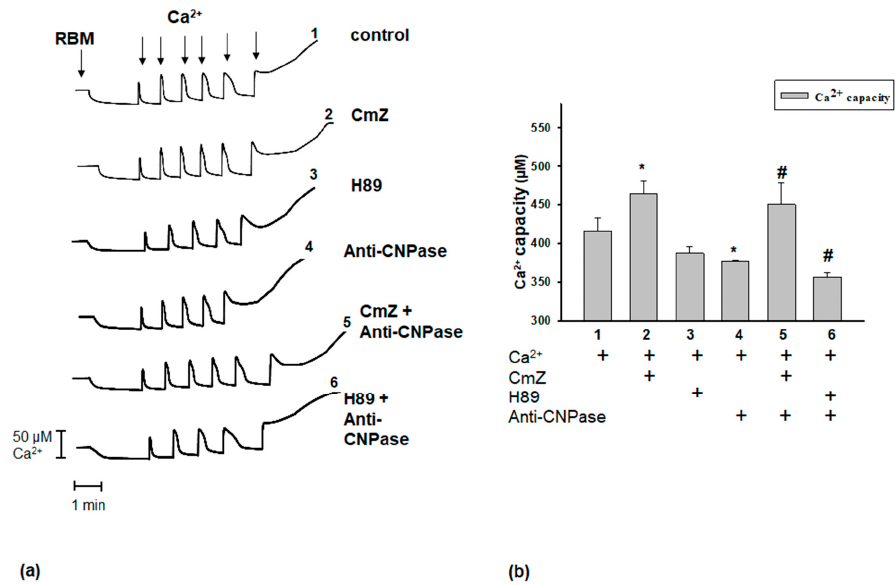
Figure 1. Effect of calmidozolium (CmZ), H89, anti-CNPase antibody, and their combined effect on Ca 2+ capacity in rat brain mitochondria (RBM). Isolated RBM (1.0 mg/mL protein) were incubated in an electrode chamber under conditions described in Materials and methods. ( a ) Representative traces of Ca 2+ fluxes in RBM. Arrows show the times at which CaCl 2 was applied (the first addition, 50 nmol of Ca 2+ per mg of protein; the subsequent addition, 100 nmol each of Ca 2+ per mg of protein). ( b ) Quantitative analysis of Ca 2+ -capacity in the presence/absence of CmZ (30 µ M), H89 (5 µ M), and anti-CNPase antibody (0.18 µ g/mL). The values shown are the means ± SD from three independent experiments; * p ≤ 0.05 vs. the Ca 2+ retention capacity without any additions, # p ≤ 0.05 compared with the Ca 2+ -capacity in the presence of anti-CNPase antibody. CNPase: 2 (cid:48) ,3 (cid:48) -cyclic nucleotide-3 (cid:48)